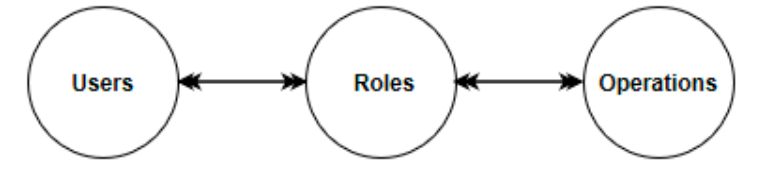
Figure 1. Users, roles, and operations.